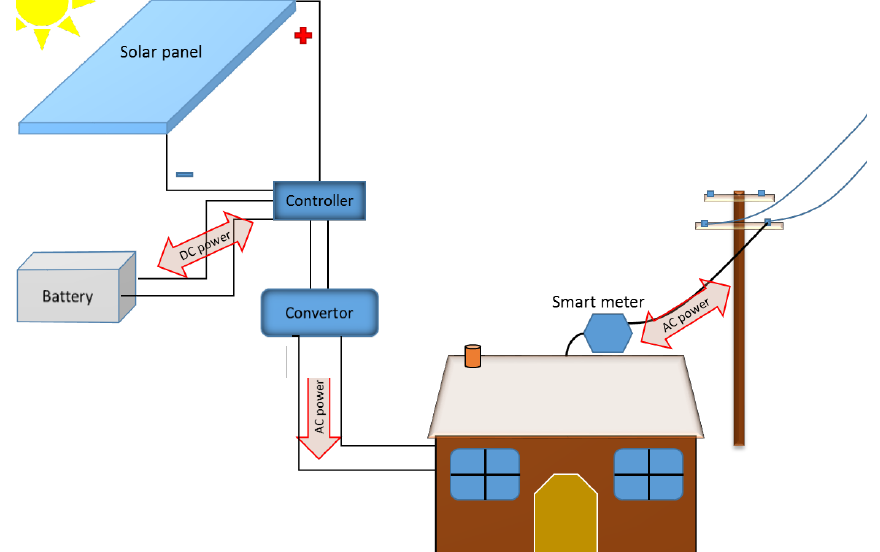
Figure 2. A scheme of the proposed grid-connected PV system.